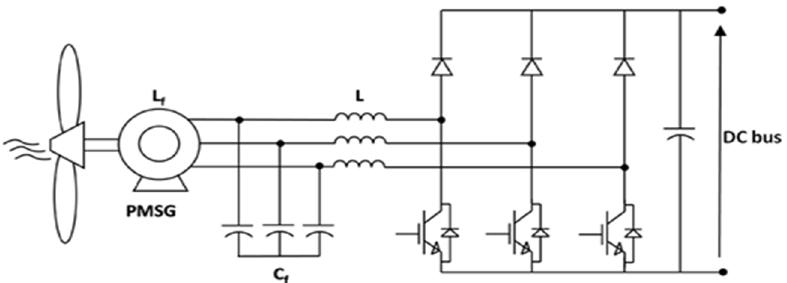
Figure 4. Single-controlled boost rectifier.